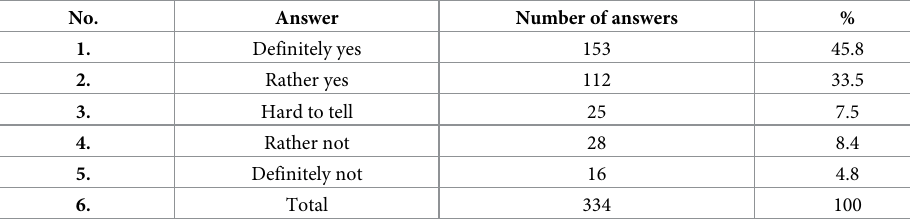
Table 10. Time-related dimension of conflict between the roles of mother and scientist. No.